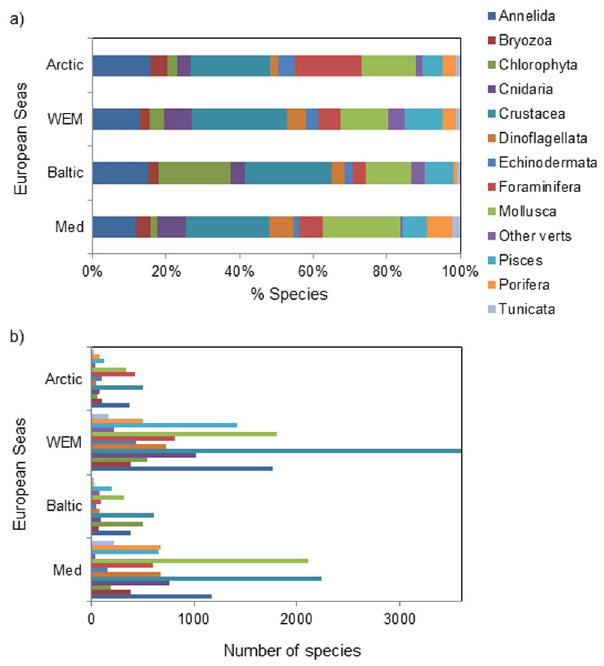
Figure 2. Comparison of species in different taxonomic groups in all four regions investigated. A) The percentage accumulation of species found per taxonomic group in each region (Arctic, Western European Margin, Baltic and Mediterranean Sea); B) The total number of species found per taxonomic group in each region (Arctic, Western European Margin, Baltic and Mediterranean Seas). (Sources: Coll et al. [9], Danovaro et al. [18], Narayanaswamy et al. [19], Ojaveer et al. [20]).